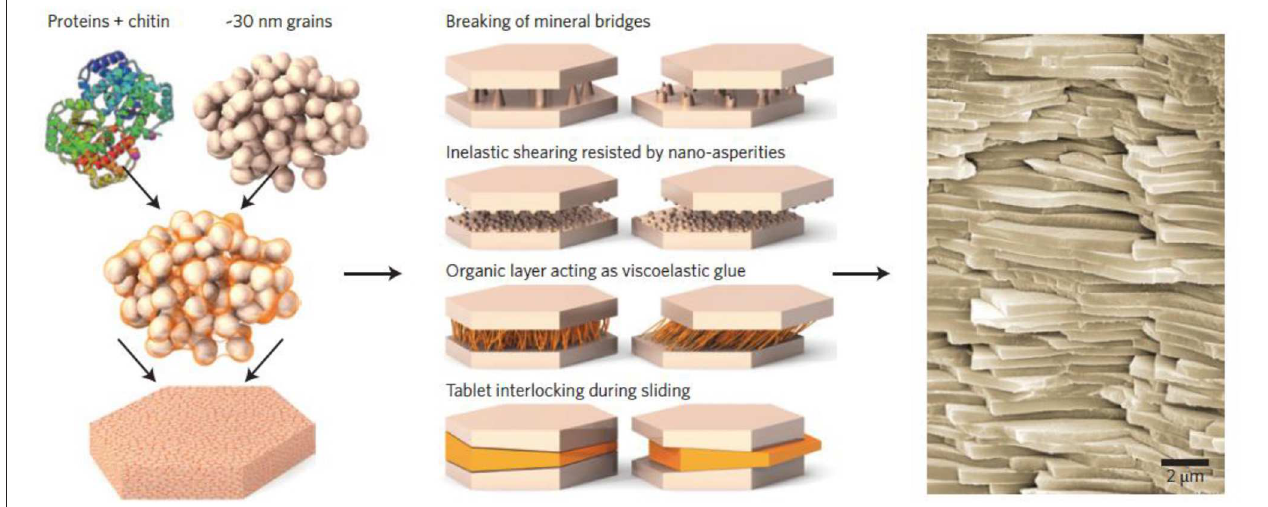
FIGURE 1 | Structural features of a nacre leading to enhanced fracture resistance at different length scales. Figure adapted from Wegst et al. (2015), with permission from Springer